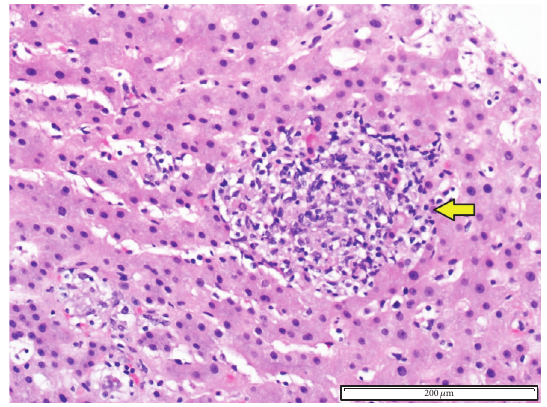
Figure 1: Hematoxylin and eosin staining (200x) of liver biopsy that demonstrates an epithelioid granuloma (arrow).